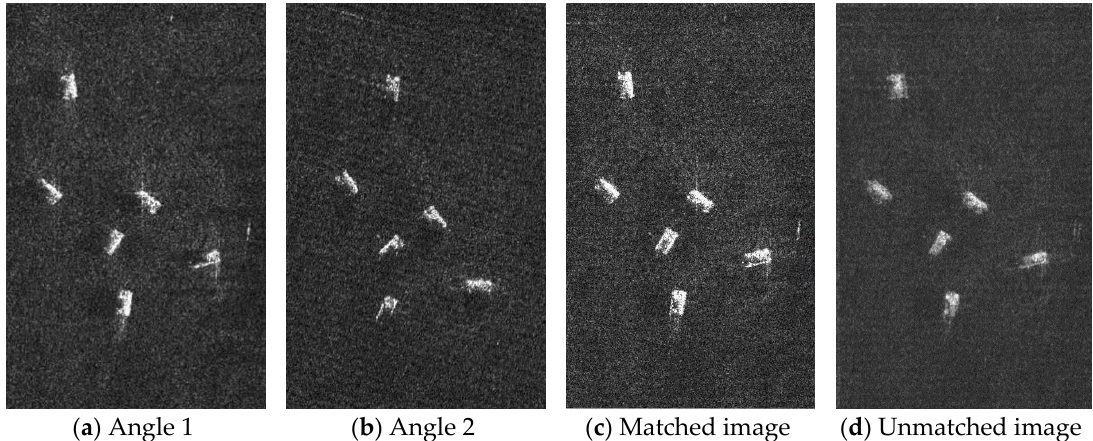
Figure 16. Image fusion results of Range–Doppler algorithm.